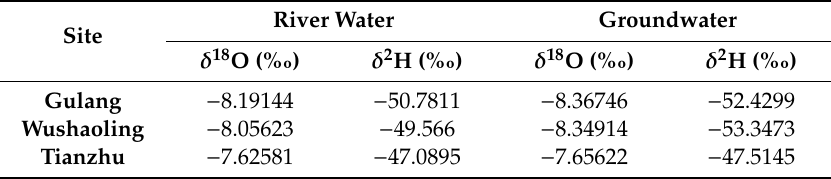
Table 8. The mean δ 18 O and δ 2 H for river water and groundwater.